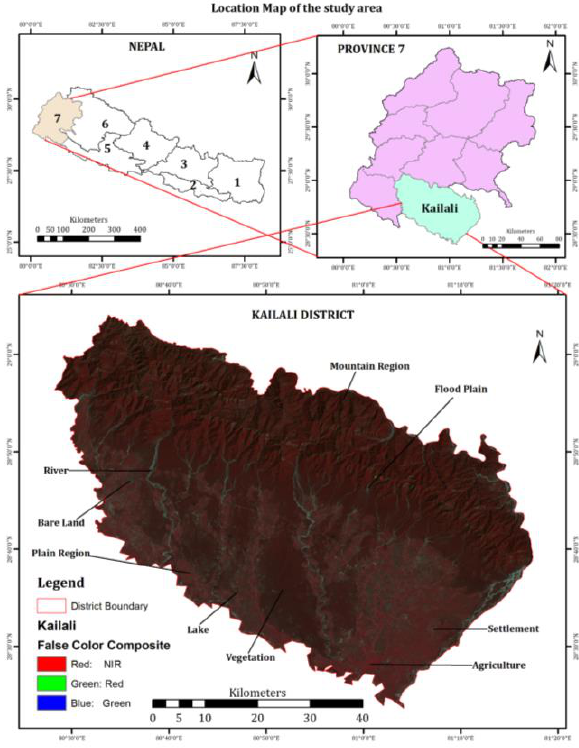
Figure 1: Location map of study